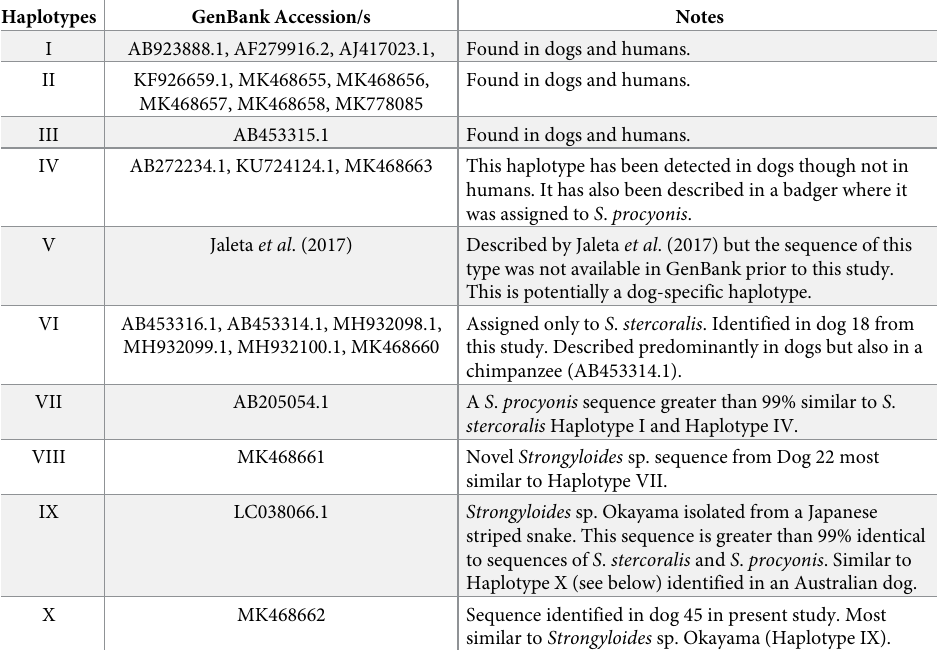
Table 2. HVR I haplotypes assigned to Strongyloides sp. based on current